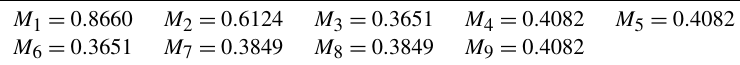
Table 6. Similarity calculation